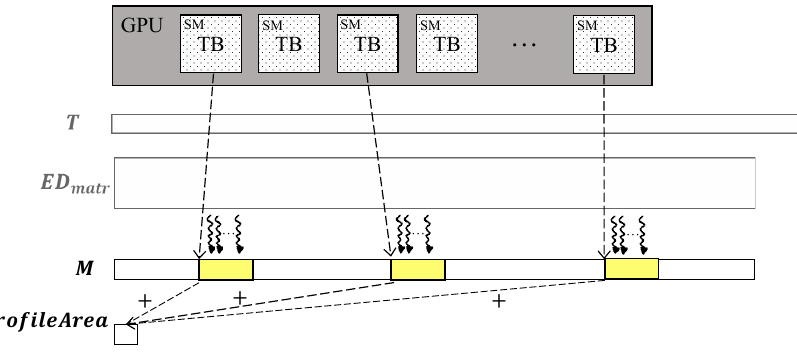
Figure 5. CUDA kernels to compute area under the curve and